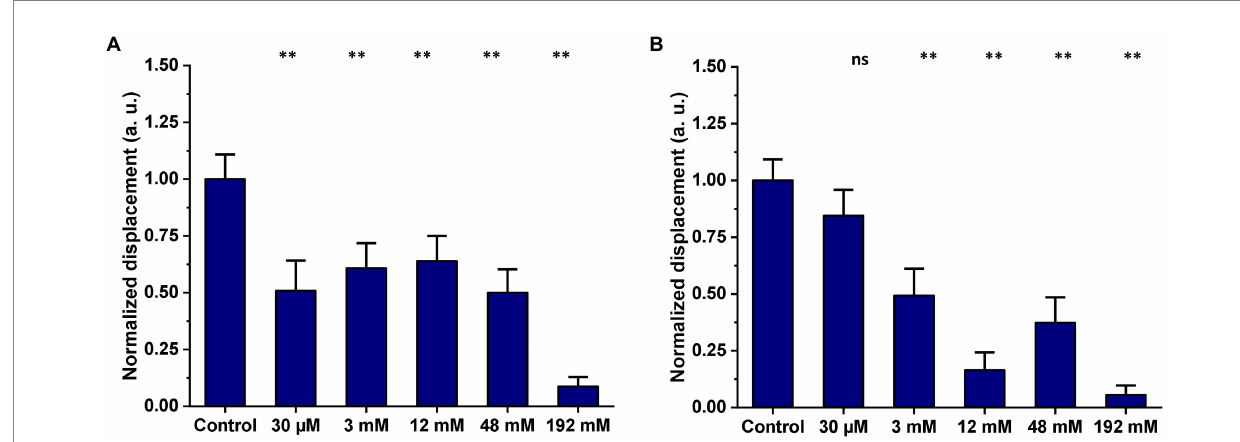
FIGURE 7 Effect of increasing concentrations of acetate on mitochondrial nanomotion after (A) a 2-h exposure and (B) overnight exposure (mitochondria isolated from HEK293T cells). Results are representative of three independent experiments. Graphs are annotated with p -values from Welch’s ANOVA, followed by Games-Howell’s multiple comparisons test; ** p < 0.001. The number of single mitochondria analyzed after 2 h incubation was: control = 55, 30